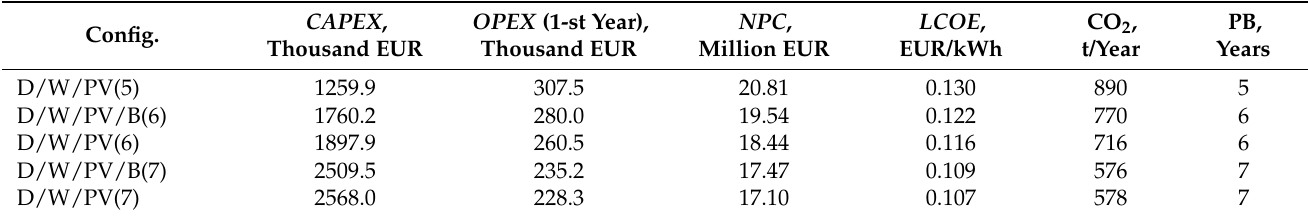
Table 10. Economic indicators of HES configuration with the additional constraint of PB.